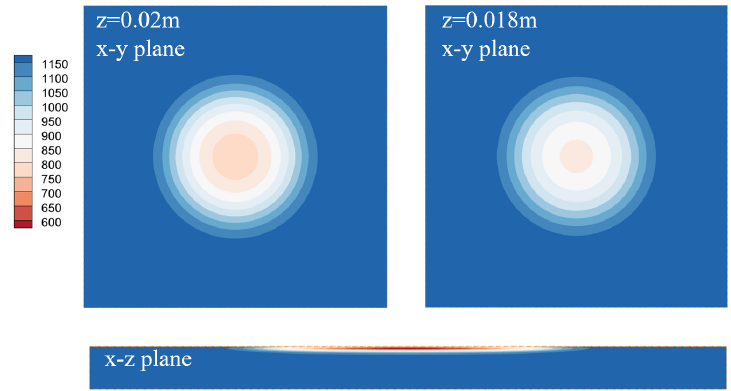
Figure 5. Density contours for different slices at t = 500 s.